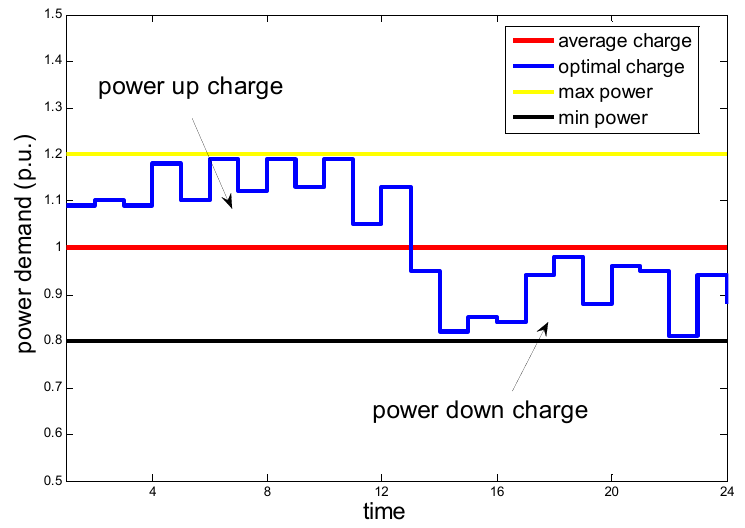
Figure 5. Demonstration of rescheduling charging